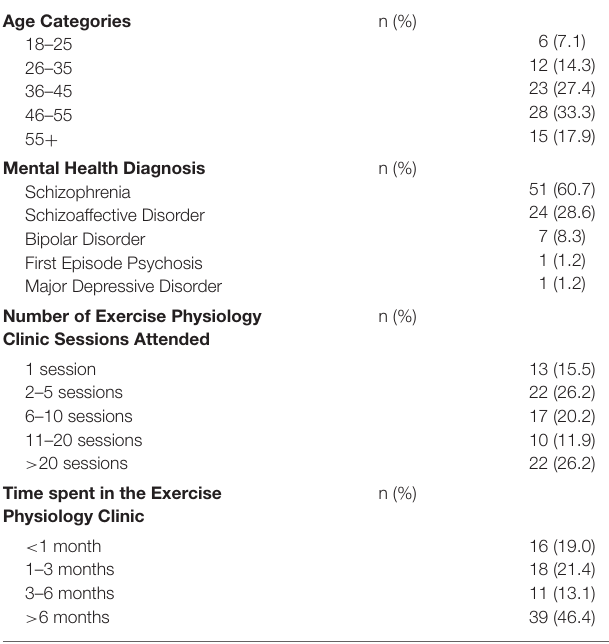
TABLE 1 | Participant demographics, clinic attendance ( n =